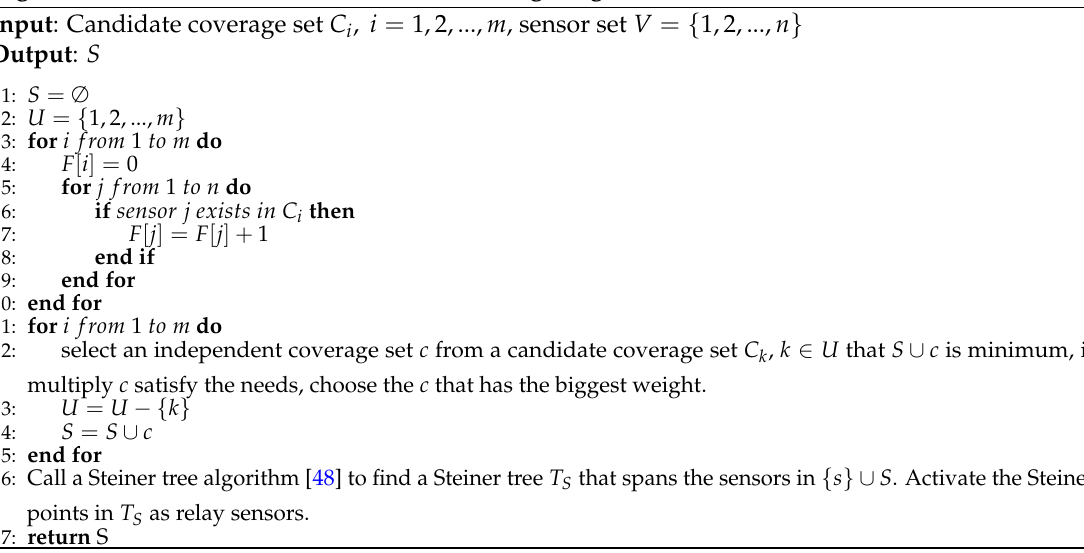
Algorithm 2 PSCA (Probabilistic Sensor Coverage Algorithm).